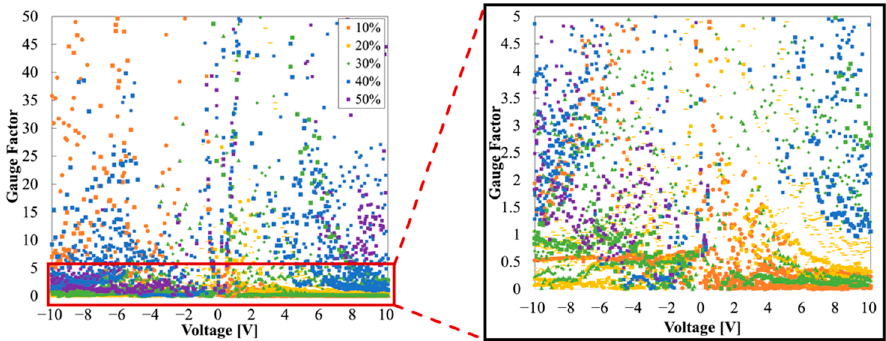
Figure 10. Overall GF of Sample A ( left ) and enlarged GF of Sample A ( right ). The individual I − V graphs for each strain of Sample B are shown in Figure 11b–d. Each graph is the result of three consecutive measurements under the same conditions.